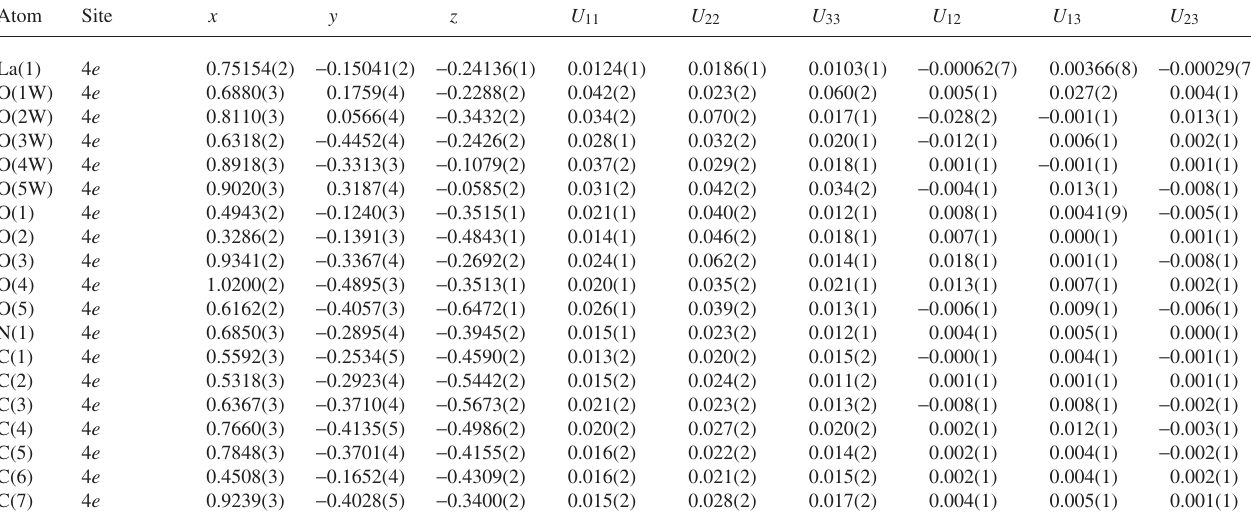
Table 3. Atomic coordinates and displacement parameters (in Å 2 )